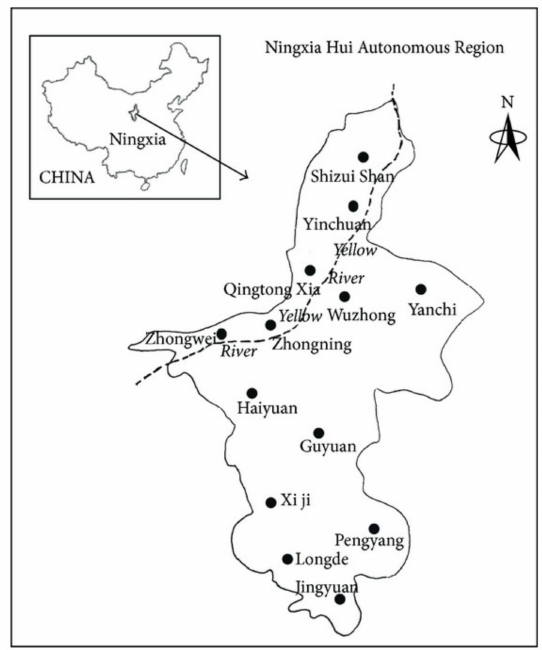
Figure 1. Location and region map of